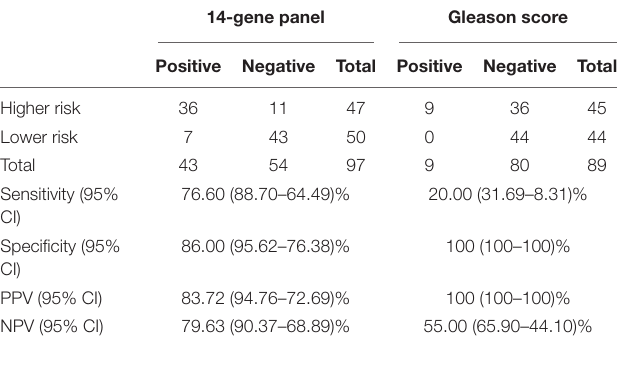
TABLE 6 | Sensitivity, specificity, PPV, and NPV of 4-Gene-Panel and Gleason score for diagnosis of higher-risk and lower-risk PCa in a retrospective Pca urine cohort.